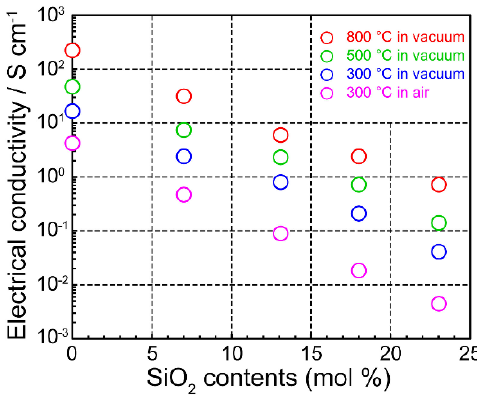
Figure 18. Electrical conductivities of trGO and trGO/SiO 2 films as a function of the silica content.